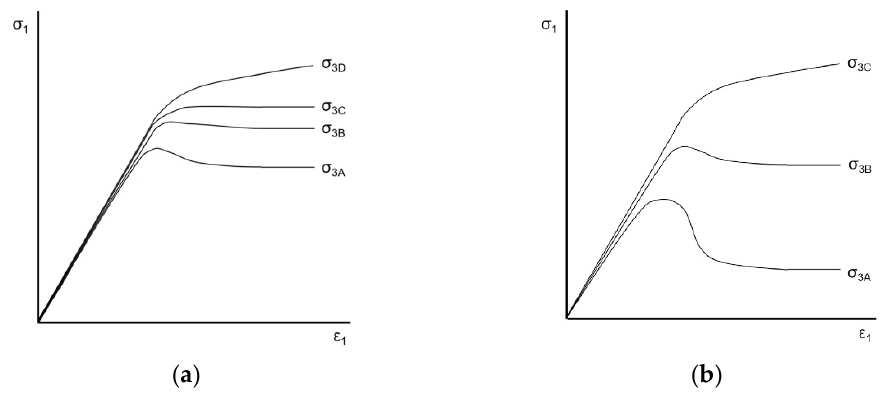
Figure 2. Illustration showing how multistage triaxial stress–strain curves were used to determine the principal and confining stresses at the brittle–ductile transition ( σ 3 *) for each formation ( a ) Multistage triaxial test result with good confining stress resolution; σ 3 * = σ 3C ( b ) Multistage triaxial test result with poor confining stress resolution; σ 3B < σ 3 * < σ 3C . Modified from Walton, 2021, and used with permission.